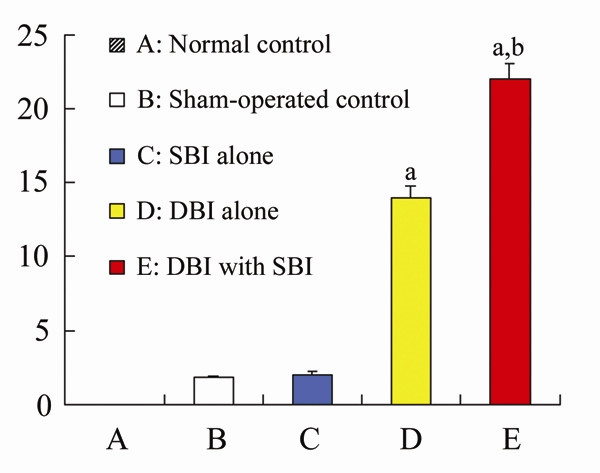
Rat neurological severity score in different groups. The bar graph shows that there were no statisticaldifferences in the NSS of rats among the normal, sham-operated control and SBI alone groups. The NSS of rats in the DBI alone and DBI with SBI group increased sharply compared with that of normal, sham-operated control and SBI alone groups. The NSS of rats in the DBI with SBI group also significantly increased compared with that in the DBI group. aP < 0.05 vs normal, sham-operated control and SBI alone groups. bP < 0.05 vs DBI alone group.